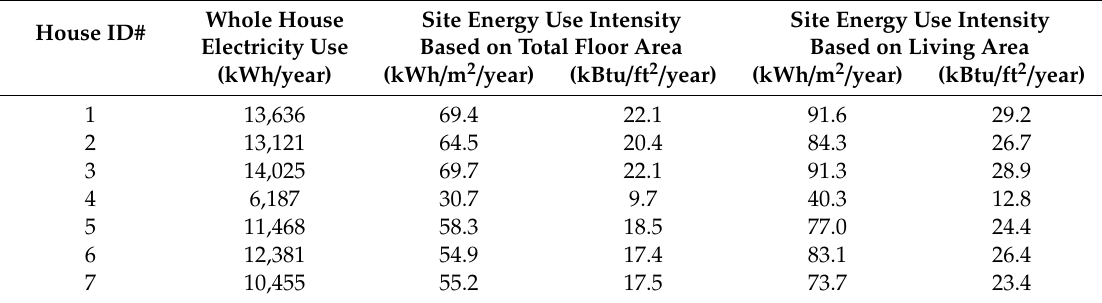
Table 3. Metered annual electricity use and site energy use intensity based on the total floor area and living